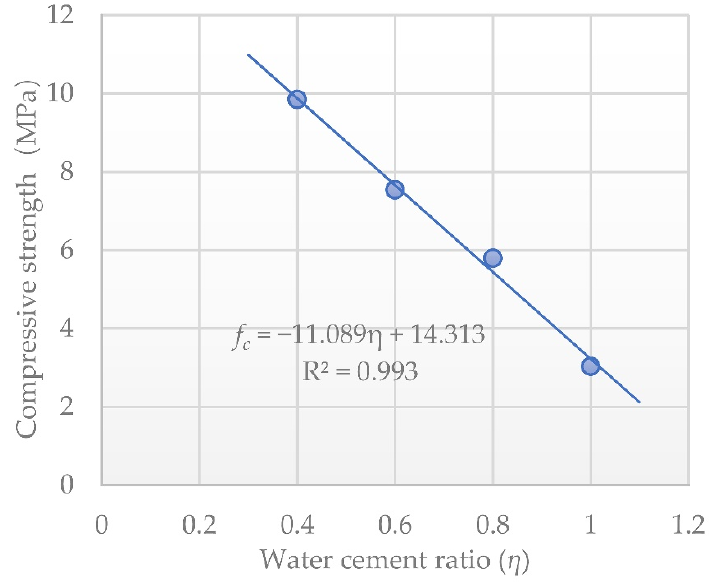
Figure 7. Compressive strength of cement sample with different water–cement ratios.